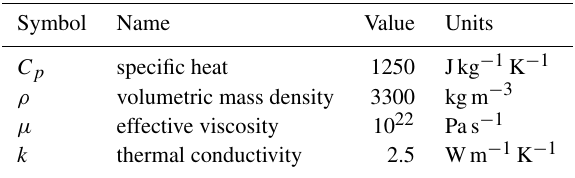
Table 1. Physical parameter used in the numerical